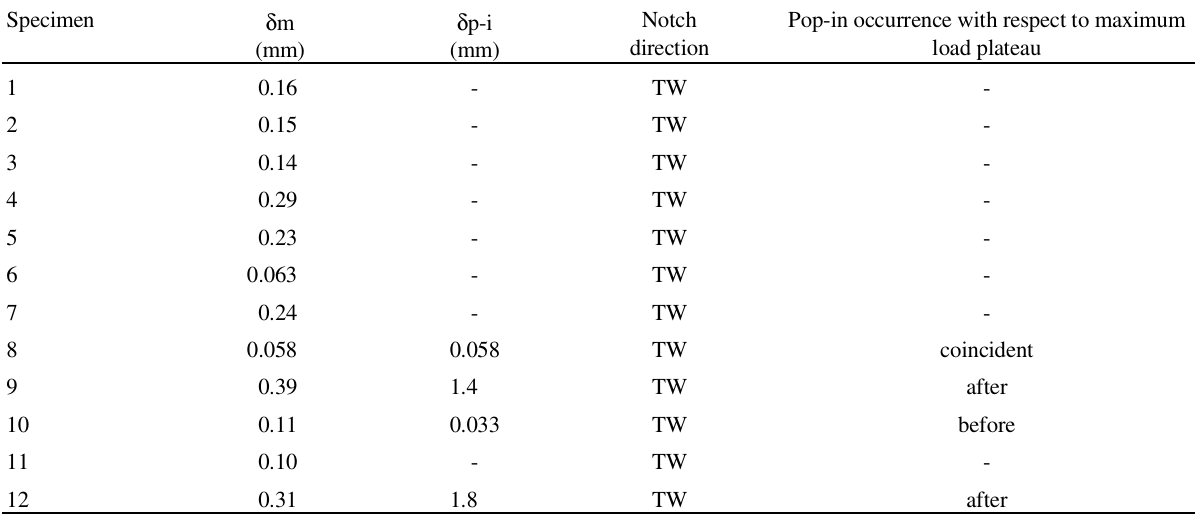
Table 3. CTOD values at maximum load and at pop-in initiation. TW specimens Specimen